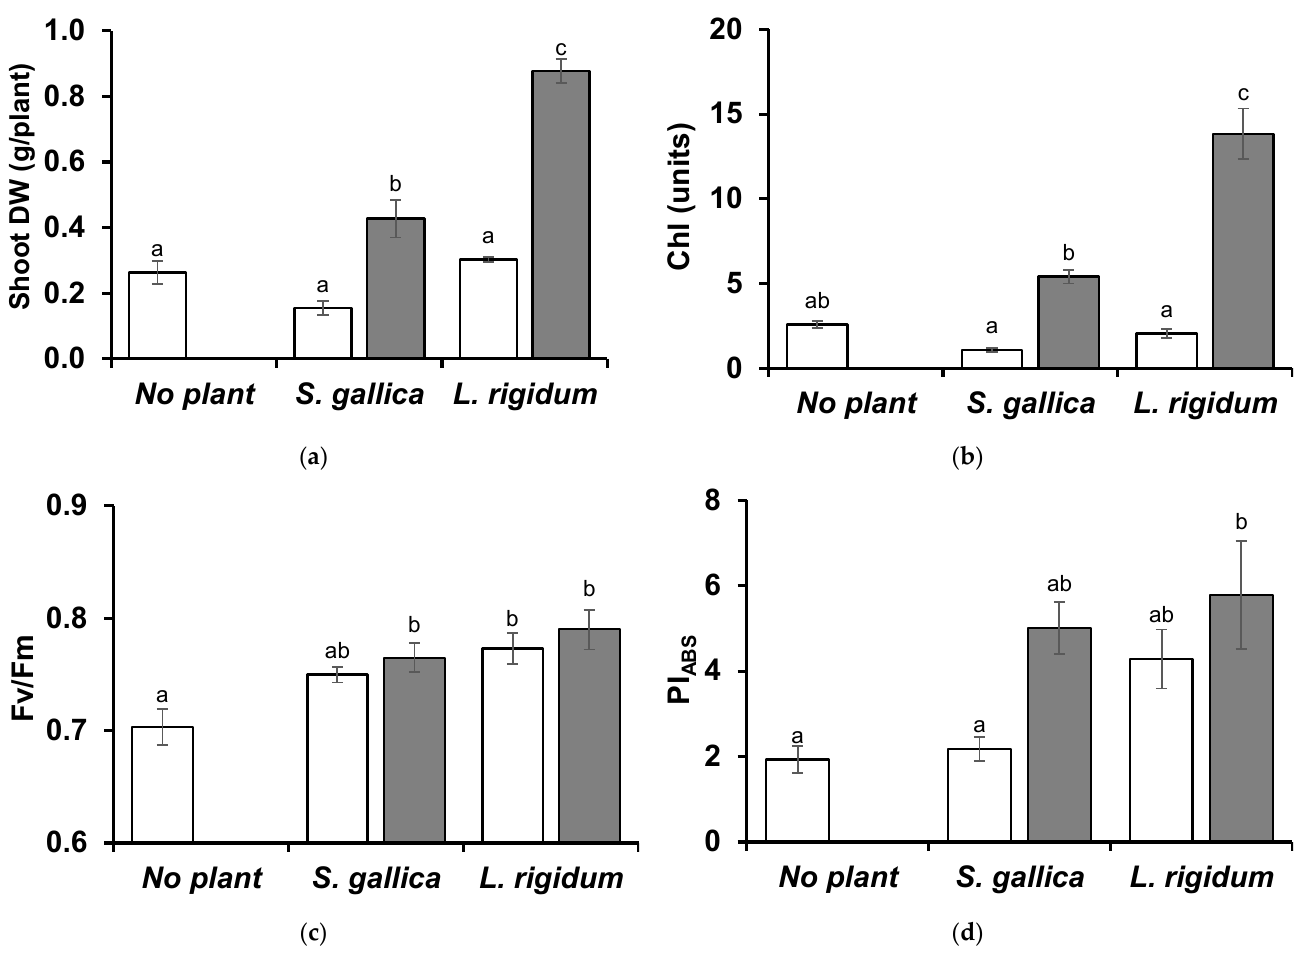
Figure 1. Wheat performance assessed by shoot dry weight (DW) ( a ), chlorophyll (Chl) content ( b ), maximum quantum yield of photosystem II (Fv/Fm) ( c ) and photosynthetic performance index (PI abs ) ( d ) in shoots of 3-week-old wheat grown in disturbed (white columns) and undisturbed (grey columns) acidic soil with arbuscular mycorrhizal fungi associated with previously grown Silene gallica L. (non-mycotrophic) and Lolium rigidum L. (strongly mycotrophic) and with no prior developer, under Mn toxic conditions. Different letters indicate statistically significant differences between the different treatments ( p < 0.05).